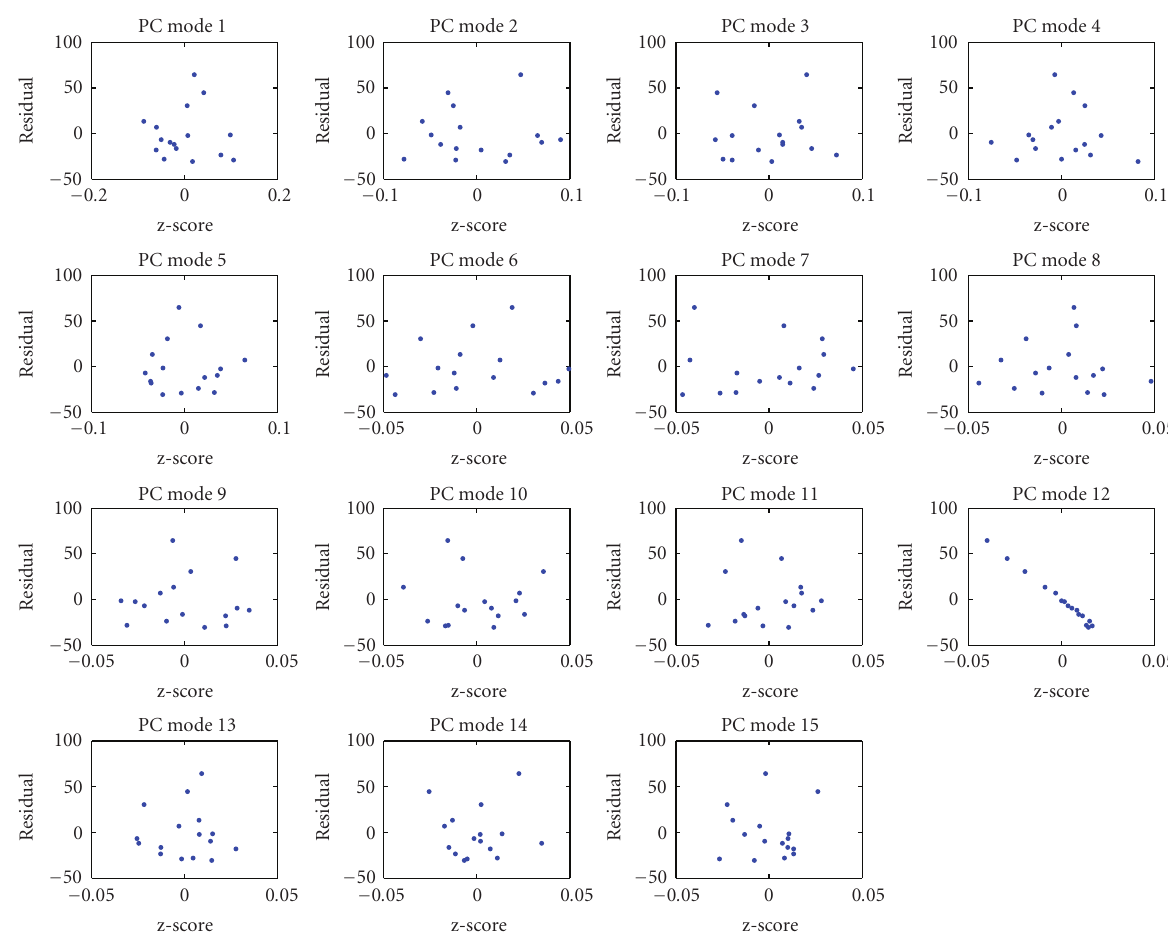
Figure 6: Correlation of PC mode parameters and frequency residual (Mode